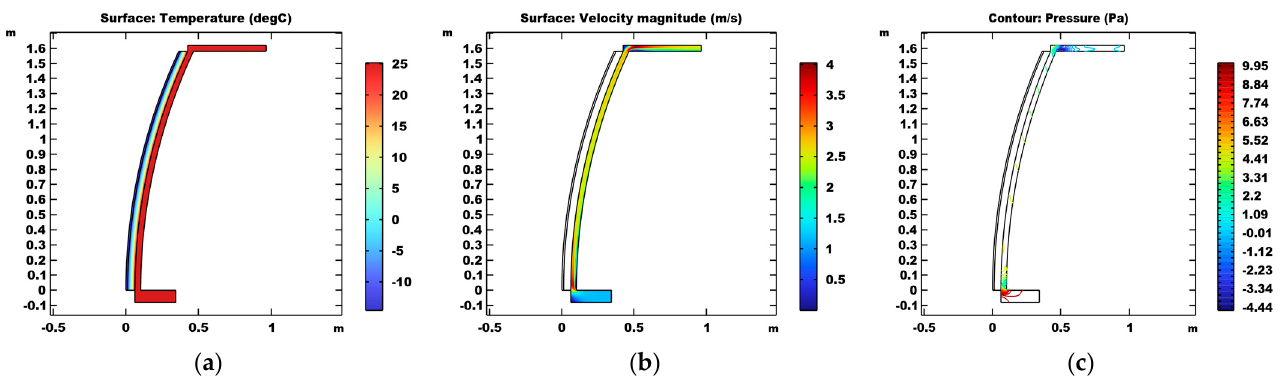
Figure A1. Distribution maps obtained from the validation process of the simulation method: ( a ) Temperature; ( b ) Velocity magnitude; ( c ) Pressure.